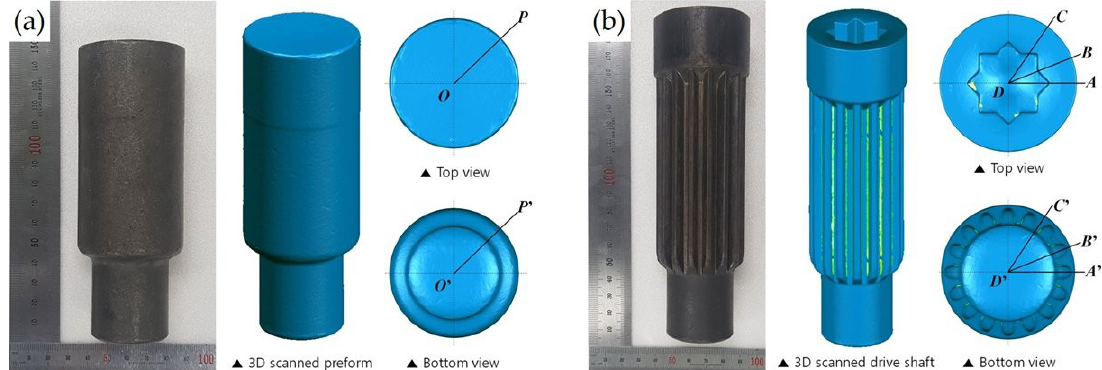
Figure 10. Preform fabricated by forward extrusion and drive shaft produced by forward-backward extrusion: ( a ) Preform and 3D scanned image; ( b ) Drive shaft and 3D scanned image.